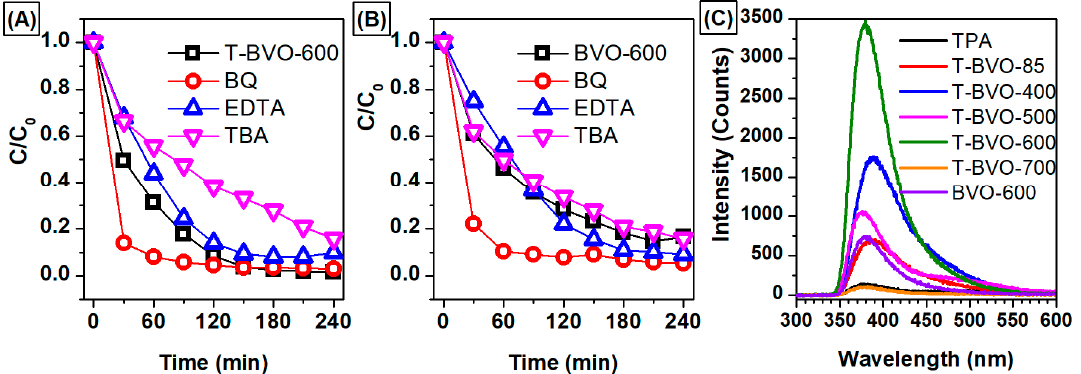
Figure 9. Trapping experiments of photocatalytic degradation of MB over ( A ) T-BVO-600, ( B ) BVO-600 samples (BQ: 1,4-benzoquinone, EDTA: ethylenediaminetetraacetic acid disodium and TBA: tert -butanol) and ( C ) PL spectra of terephthalic acid ( λ ex = 315 nm) in the presence of BiVO 4 samples.